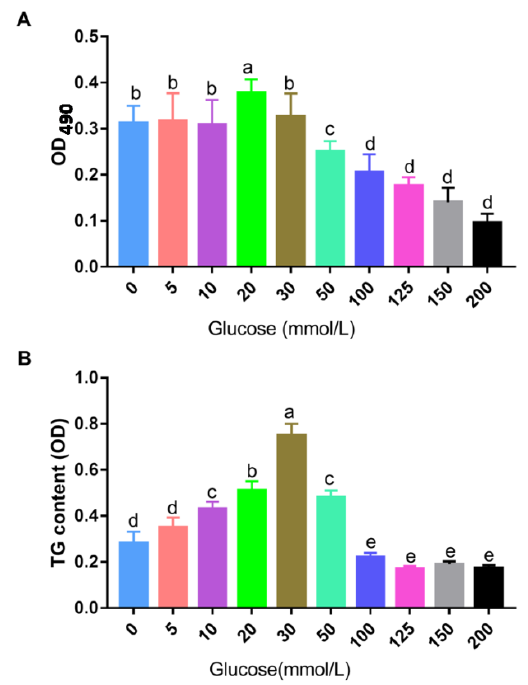
Figure 1. Effects of different concentrations of glucose on the activity and TG content of Landes goose primary hepatocyte. ( A ): Effect of glucose on Landes goose primary hepatocytes’ activity; ( B ): Intracellular TG content of Landes goose primary hepatocytes treated with glucose. Different lowercase letters in the bar indicate a significant difference in different groups ( p < 0.05, n = 9).